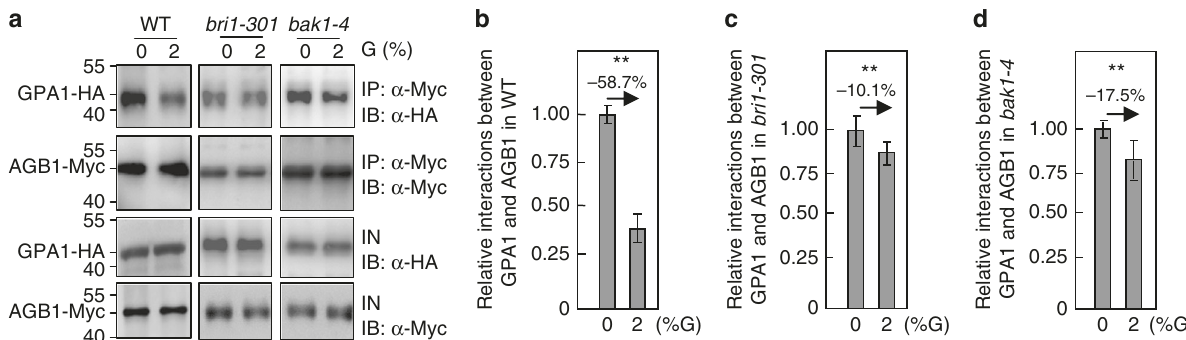
Fig. 7 BRI1 and BAK1 affect the interactions between GPA1 and AGB1. a BRI1 and BAK1 in fl uences the interactions between GPA1 and AGB1 in Arabidopsis , respectively. The wild type, bri1-301 , and bak1-4 leaf protoplasts co-transformed with 35S:AGB1 - Myc and 35S : GPA1 - HA plasmids were grown in darkness for 14 h, and then treated without or with 2% glucose (G) for 5 h. Total proteins from these leaf protoplasts were incubated with anti-Myc-Tag mouse mAb conjugated agarose beads, and detected using anti-Myc and anti-HA antibodies, respectively. IN input; IP immunoprecipitation. b – d Quanti fi cation of relative interactions between GPA1 and AGB1 in wild type ( b ), bri1-301 ( c ) and bak1-4 ( d ) leaf protoplasts treated without or with 2% glucose as shown in a . The ratio was shown as immunoprecipitated GPA1-HA to input GPA1-HA. Values are given as mean ± SD ( n = 3) relative to the value for 0% glucose, set at 1. Values in b – d are given as mean ± SD, ** P < 0.01 compared with the value for 0% glucose treatment by Student ’ s